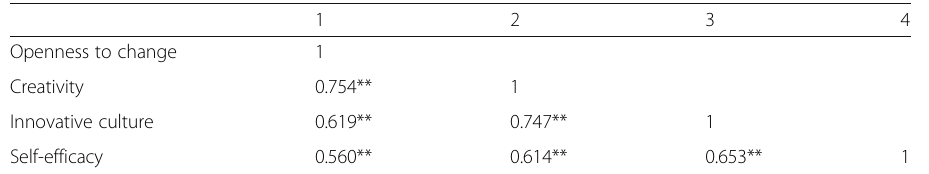
Table 1 Correlation matrix